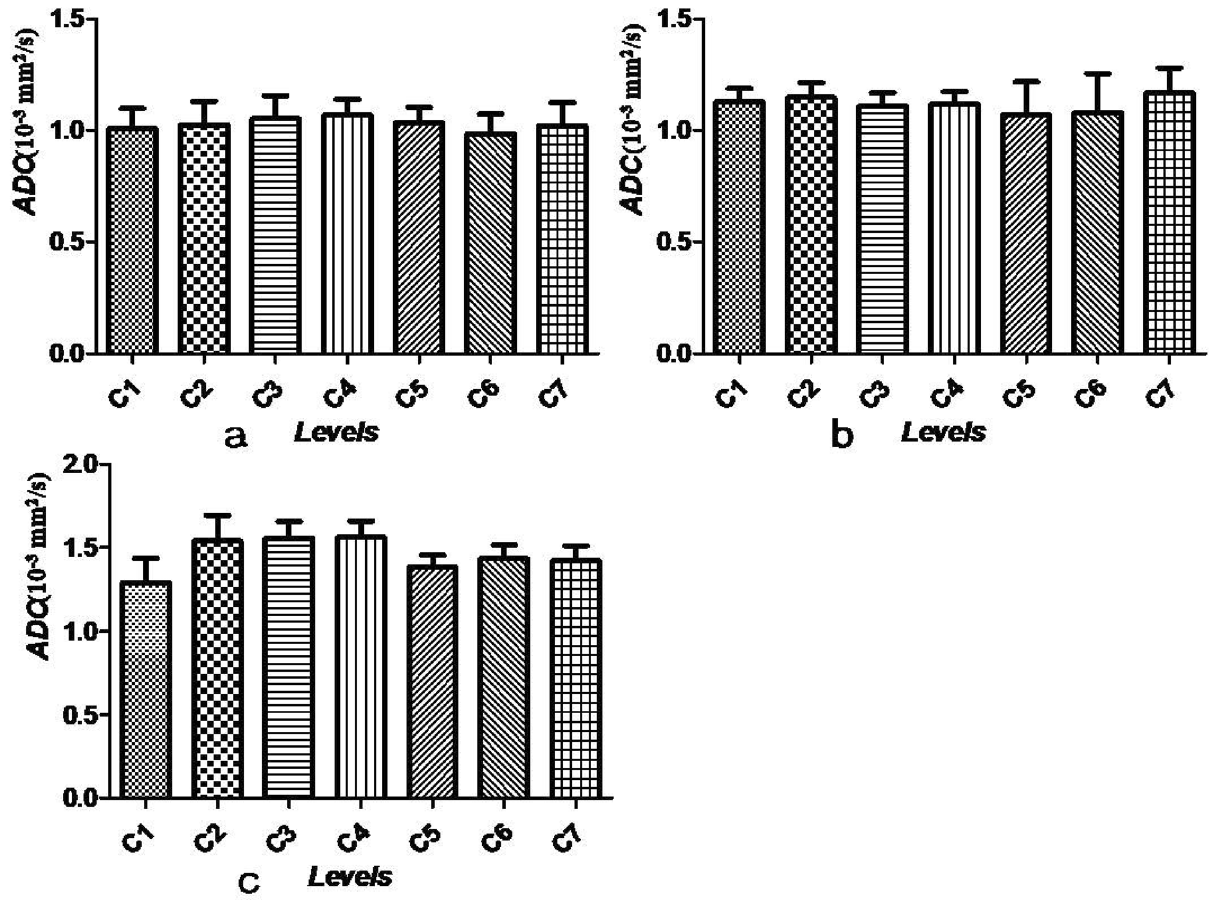
Figure 3. ( a – c ) ADC values (mm 2 /s: mean ± SEM) at all cervical levels in controls, outside the area of the visible syrinx and the area of the visible syrinx,